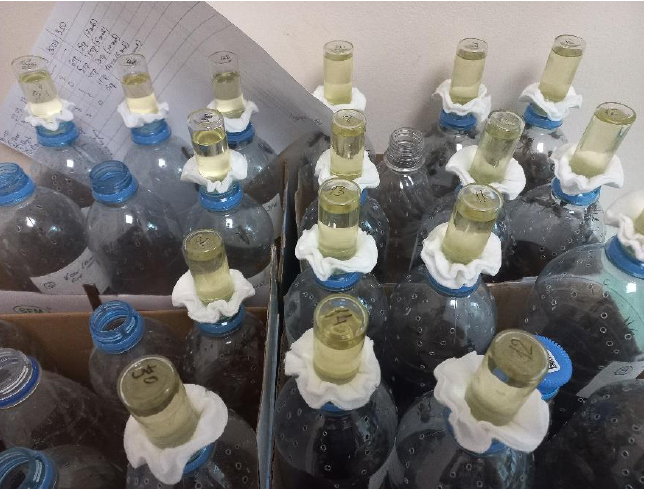
Figure 1. Laboratory maintenance of the worker honey bees for Vairimorpha ceranae cultivation. In-